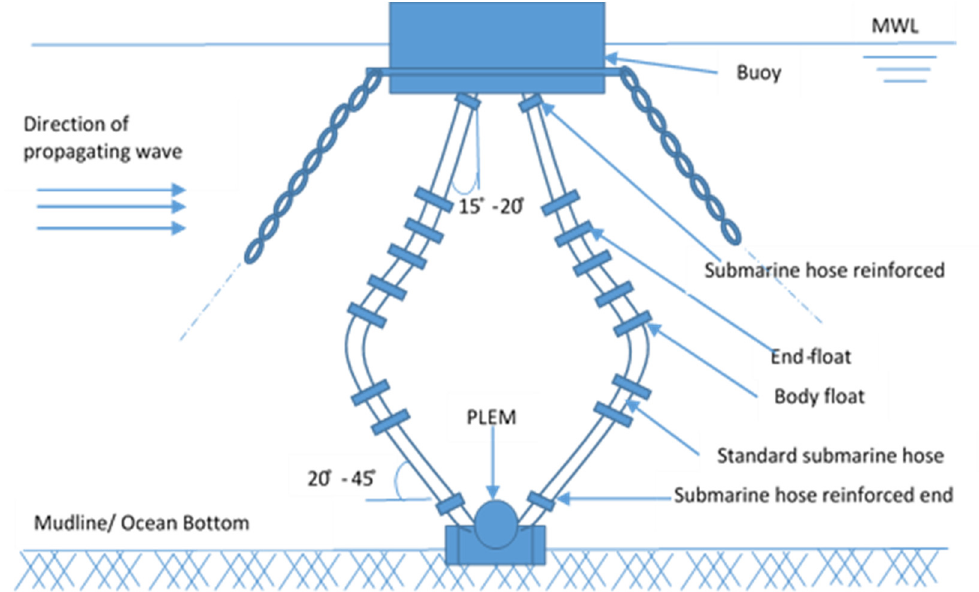
Figure 9. An illustration of Chinese-lantern hose configuration.